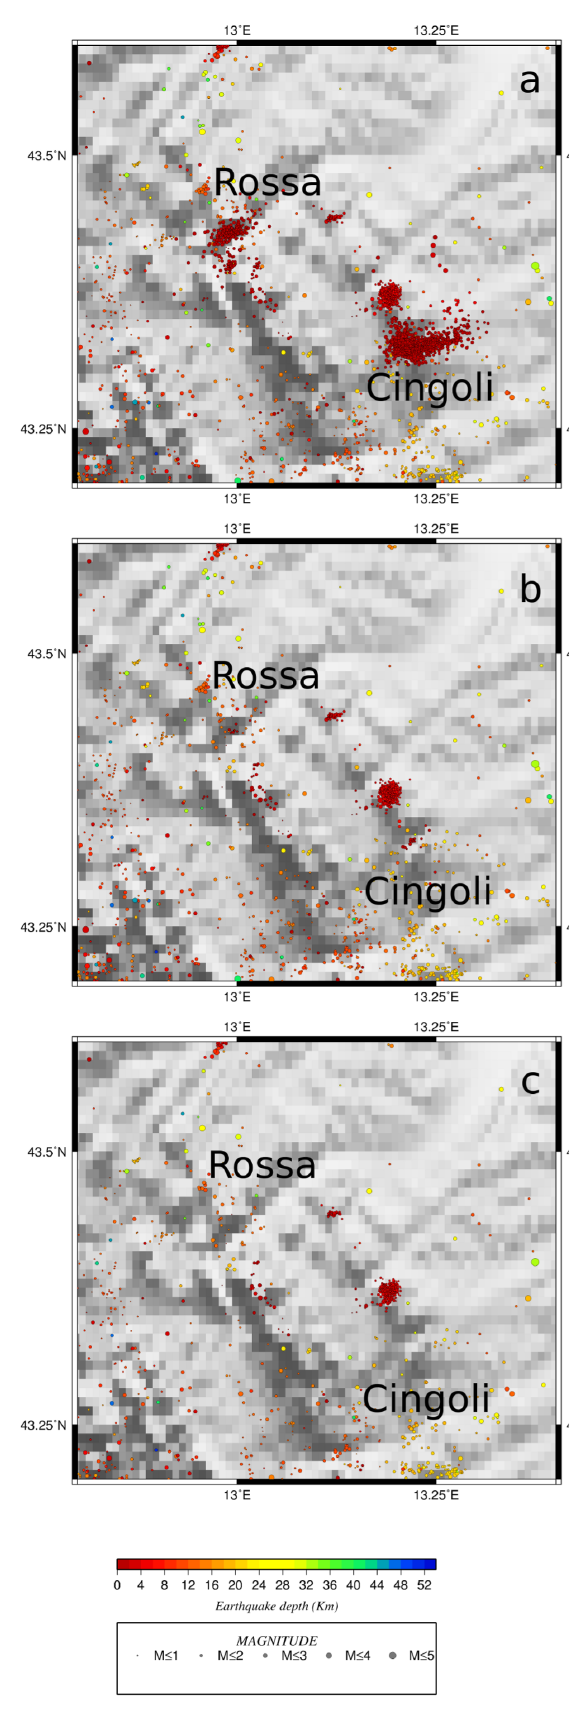
Figure 13. Zoom of seismicity in a zone comprising quarry areas “Cingoli” and “Rossa”. (a) Whole catalogue (as in Figure 2). (b) “Tec- tonic-source” events (as in Figure 10). (c) Catalogue after eliminating day-time